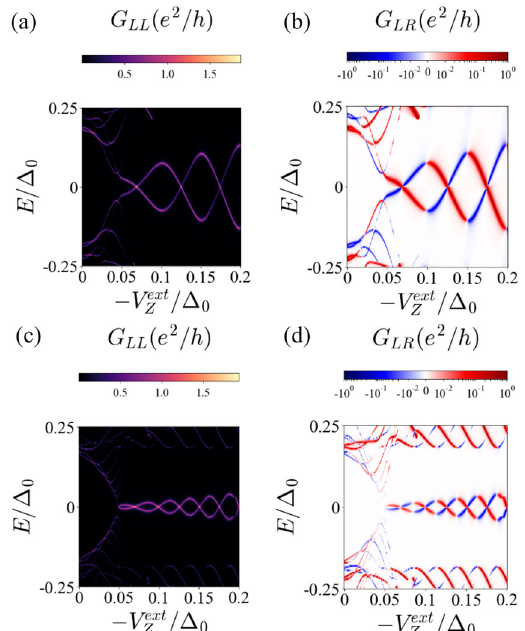
Fig. 4 Conductance spectra for the clean nanowire. a Local ( G LL ) and b non-local conductance ( G LR ) signatures for a nanowire of length 2.25 μ m, with a potential pro fi le as shown in Fig. 1c. c Local and d non-local conductance spectra for a nanowire of length 4.5 μ m, with a potential pro fi le as shown in Fig. 1c. Both the local and the non-local conductances show the bulk gap closing and reopening, which signals a topological transition, followed by the emergence of a near-zero energy state with a splitting that oscillates as a function of the externally applied magnetic fi eld, V ext Z . The bare superconducting gap in the parent superconductor the scale for all energies. G LL , G LR are plotted as a function of the biasing energy e , and the externally applied magnetic fi eld V ext Z and are measured in units of e 2 / h , which is the conductance quantum, e being the electronic charge and h being Planck ’ s constant. The colorbars represent the magnitude of the DOS,